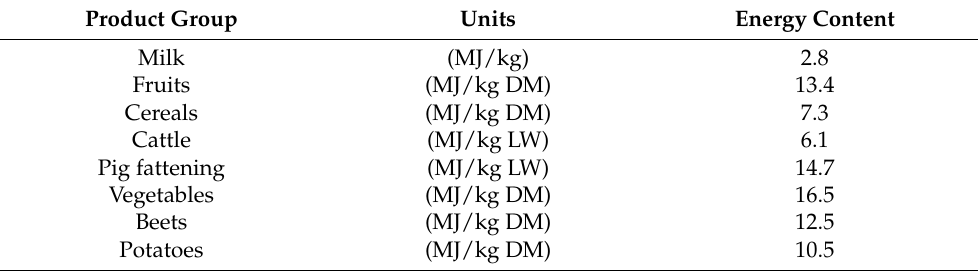
Table A4. Human digestible energy content of product groups. DM = Dry Matter, LW = Live Weight.